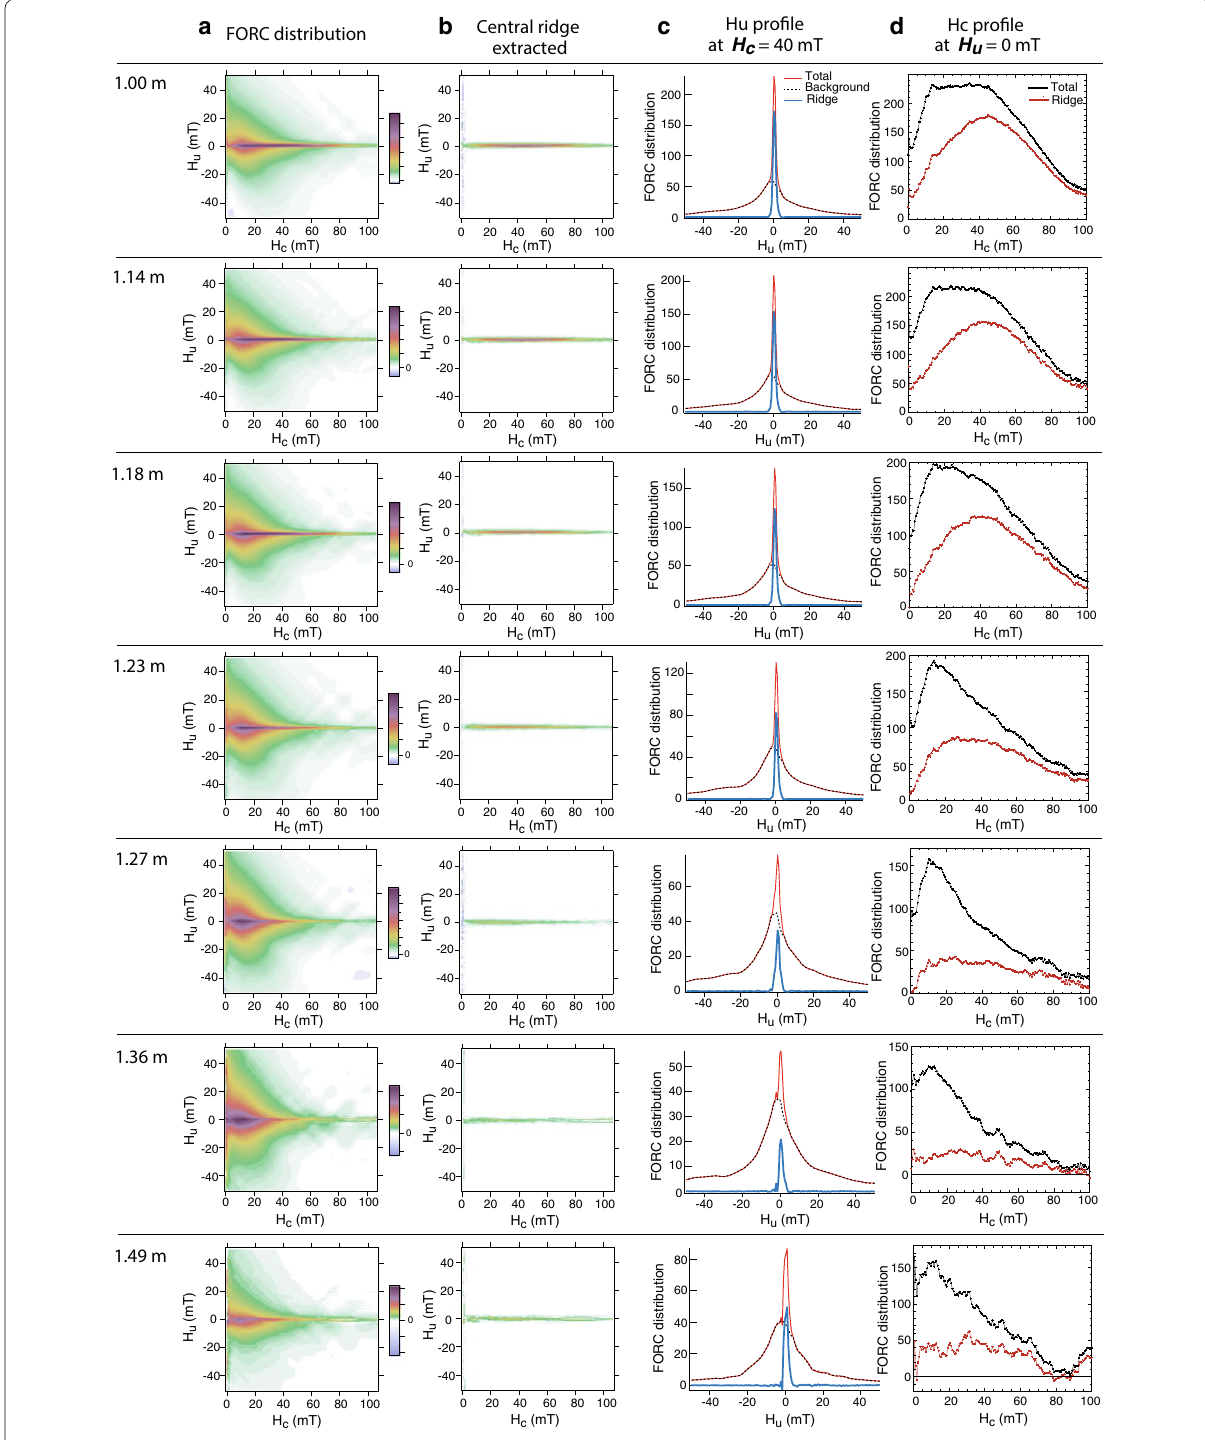
Fig. 3 First-order reversal curve (FORC) results for samples from seven depth horizons shown in Fig. 2, indicating a FORC diagrams, b the central ridge component extracted from the respective FORC diagrams (Egli et al. 2010), c profiles of magnetostatic-interaction field ( H u ) distributions at a coercivity ( H c ) of 40 mT: the central-ridge component (blue), the background component with vertical spread (black), and the total of the two (red), and d profiles of coercivity distributions at zero interaction field ( H u 0): the central-ridge component (red) and the total =